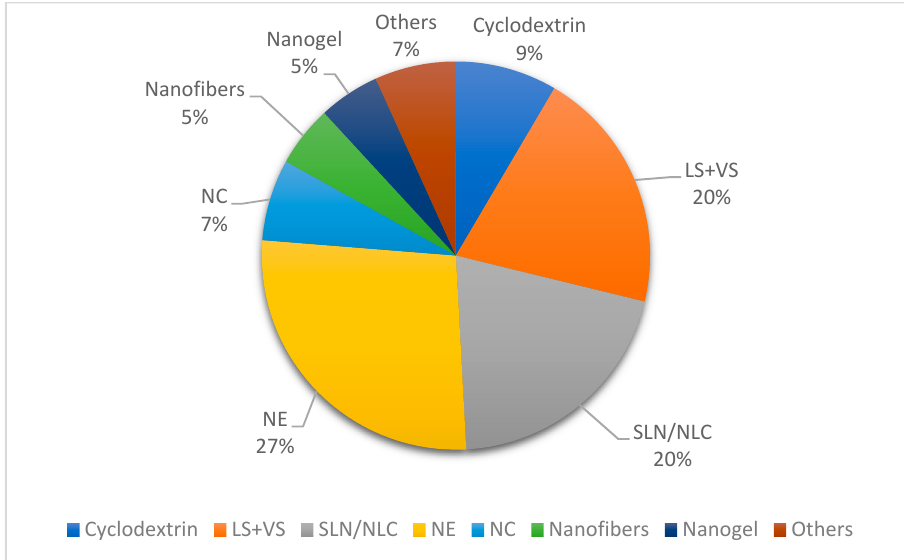
Figure 5. Nanostructured systems used in the encapsulation of essential oils containing terpenes and isolated terpenes as bioactive compounds for topical formulations. LS, liposomes, VS, vesicular systems, SLN, solid lipid nanoparticles, NLC, nanostructured lipid carriers, NE, nanoemulsions, NC, nanocapsules.